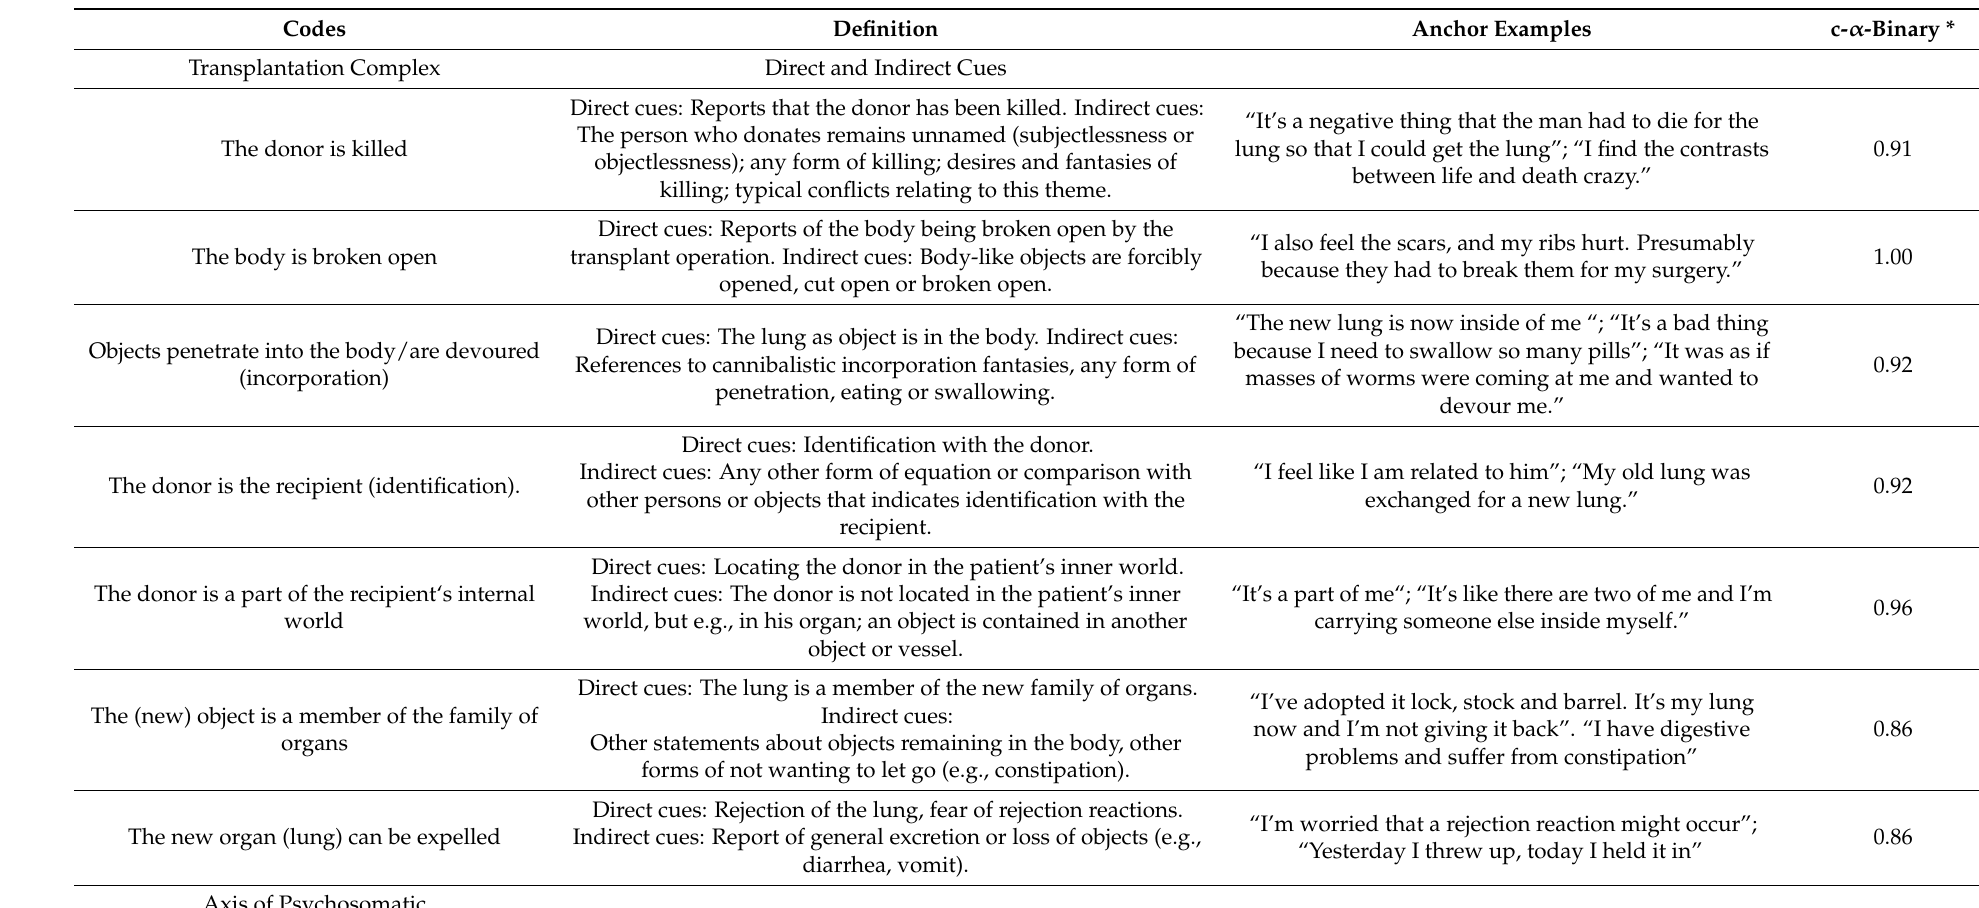
Table 2. Codes, definition, anchor examples and Krippendorff’s alpha coefficients (c- α -binary)